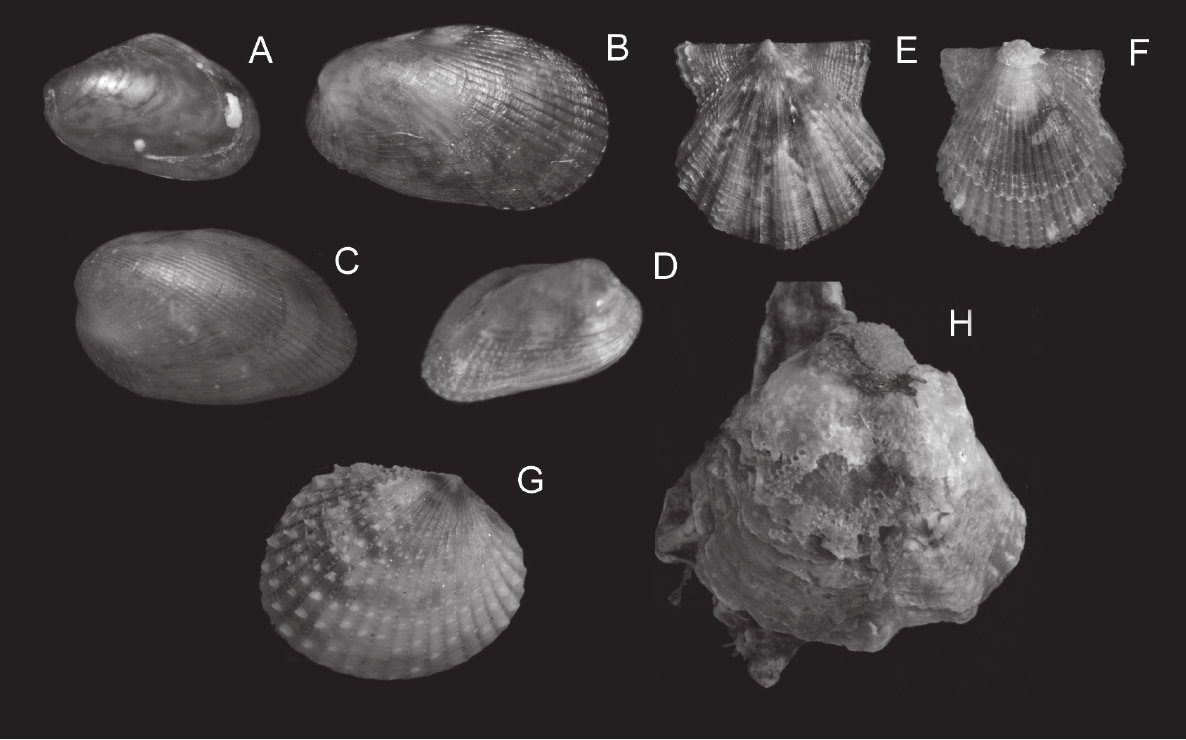
Fig . 5. – epifaunal bivalves of Zostera marina . outside view of: a, left valve of Mytilaster minimus (shell length: 2.1 mm); B, left valve of Musculus costulatus (3.6 mm); C, left valve of Modiolarca subpicta (3.4 mm); d, right valve of Gregariella semigranata (0.9 mm); e, left valve of Chlamys flexuosa (4 mm); f, left valve of Chlamys opercularis (3 mm); g, right valve of Parvicardium scriptum (3.8 mm); H, left valve of Anomia ephippium (maximum diameter: 4.1 mm) on Ocenebra erinacea